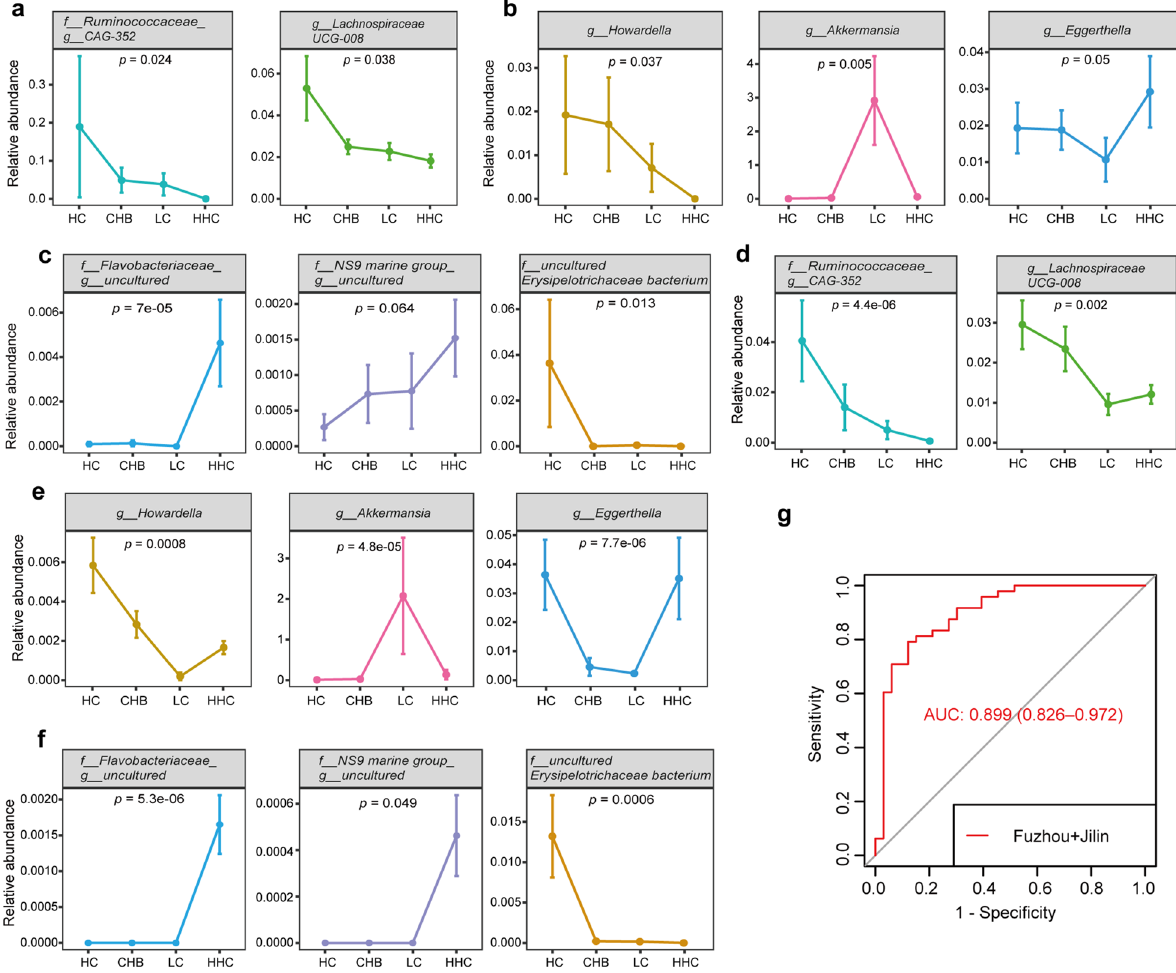
Fig. 5 The alterations of microbial markers during disease progression. a Alterations of genera overlapped in the LC-associated genera and the HCC-associated genera in Fuzhou samples. b Alterations of LC-associated genera in Fuzhou samples. c Alterations of HCC-associated genera in Fuzhou samples. d Alterations of genera overlapped in the LC-associated genera and the HCC-associated genera in Jilin samples. e Alterations of LC-associated genera in Jilin samples. f Alterations of HCC-associated genera in Jilin samples. g ROC curve of the RF model based on eight genera for discriminating HCC and LC in the combined dataset of Fuzhou and Jilin